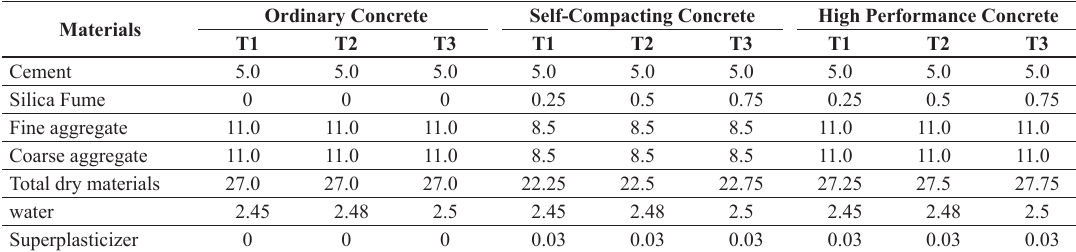
Table 1. Proportions of materials of concrete traces.